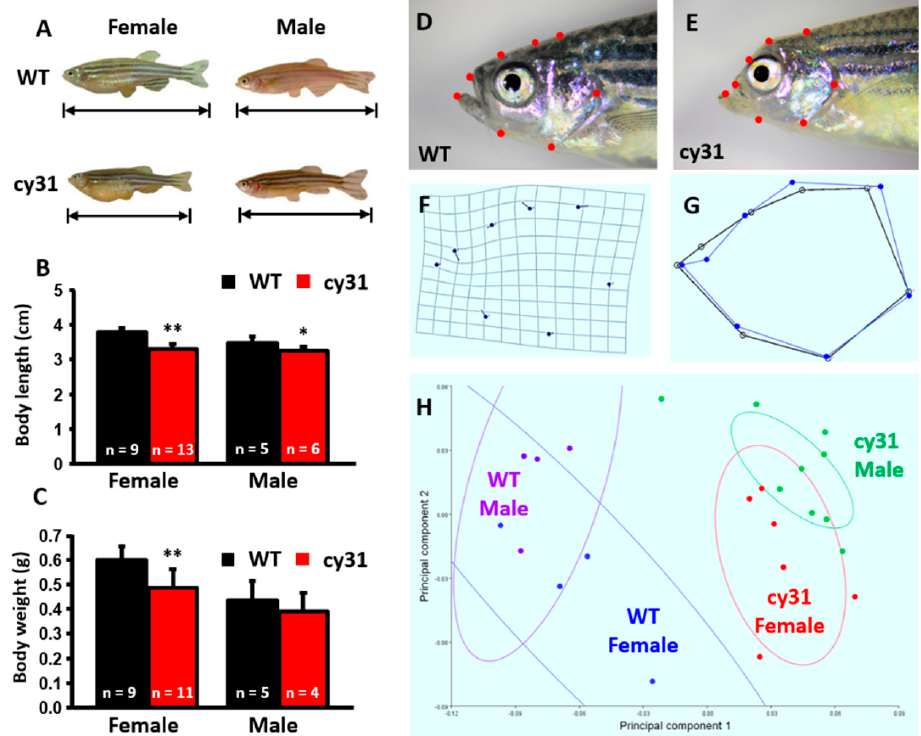
Figure 3. Morphological comparison between wild type and Tg(Ola.Sp7:N1aICD) cy31 adult fish. ( A ) Appearance of WT and Tg(Ola.Sp7:N1aICD) cy31 (cy31) transgenic fish in both genders aged 6 month old. ( B , C ) Statistical analysis and comparison of male / female body length ( B ) and body weight ( C ). ( D – G ) Morphometric analysis of the head in both WT and cy31 transgenic fish. ( H ) Principal component analysis (PCA) of WT and cy31 transgenic fish in both genders. Significance was tested ** p < 0.01; n = fish number).